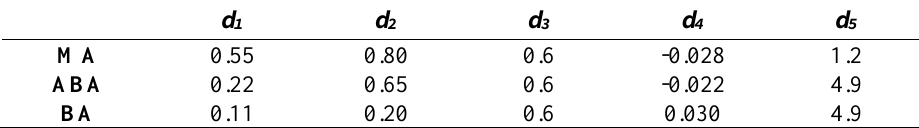
Table 5: JC damage parameters calibrated against experimental